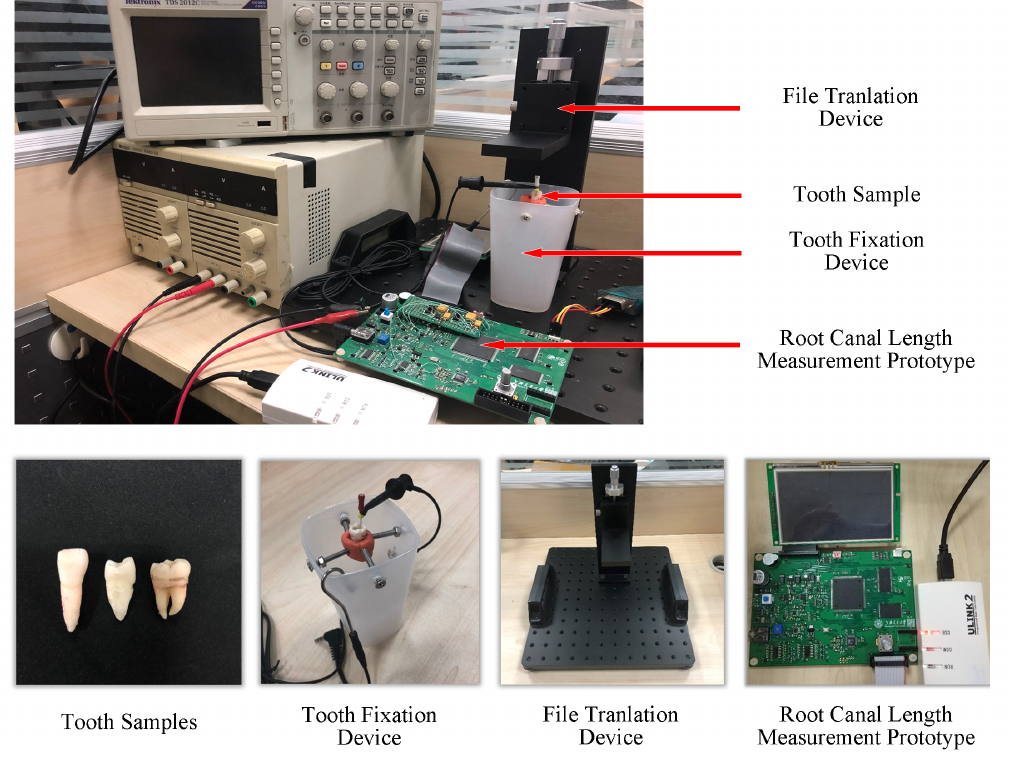
Figure 2. Experimental